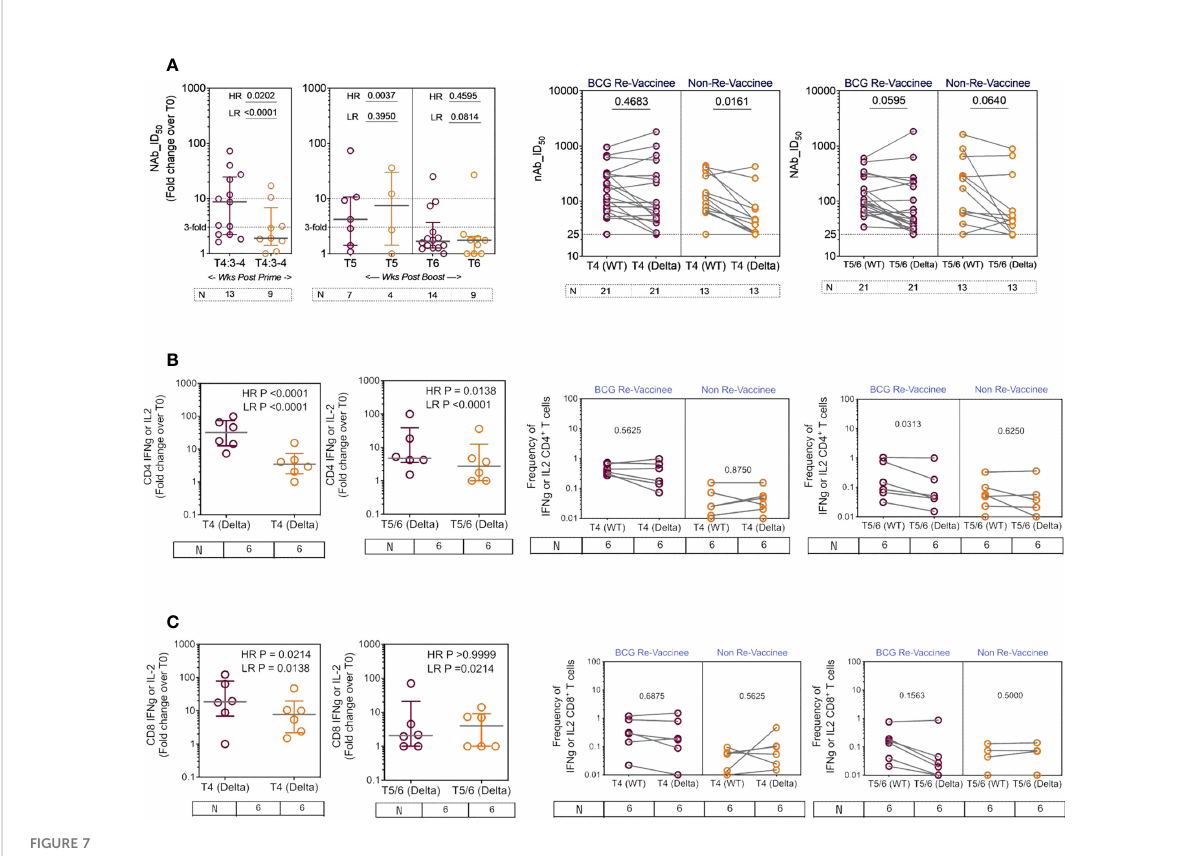
FIGURE 7 The breadth of the spike response in BCG-RV and BCG-NRV to Wild-type and Delta variant (B1.617.2). Cross-sectional analysis of (A) neutralizing antibody (nAb ID 50 ) and (B, C) CD4+ and CD8+ T cell responses to the Delta variant (B1.617.2) in samples collected from COVISHIELD ™ vaccinated BCG-RV (purple circles) versus BCG-NRV (orange circles) at 3-4 weeks post-prime (T4:3-4), 6-7 weeks post boost (T5) and 20-23 weeks post boost (T6). Grouped scatter plots depict the median (horizontal grey line) and interquartile range of fold change in nAb ID 50 or frequencies of IFN- g or IL-2 over baseline. Paired line graphs for comparison of (A) neutralizing antibody (nAb ID 50 ) and (B, C) CD4+ and CD8+ T cell responses to the reference wild-type versus Delta variant (B1.617.2) in matched samples collected from COVISHIELD ™ vaccinated BCG-RV (purple circles) and BCG-NRV (orange circles) at 2-4 weeks post prime (T4) and 6-7 weeks (T5) or 20-23 weeks (T6) post- boost. PBMCs were stimulated with Spike peptide pool to the delta strain (B1.617.2) and its matched reference WT (0.06 nM) for 20 hr. CD4+ and CD8+ T cells were analyzed for intracellular expression of IFN- g or IL-2. Statistical signi fi cance was determined by Kruskal-Wallis test with Dunn ’ s correction for line graphs and Wilcoxon matched paired t-test for scatter